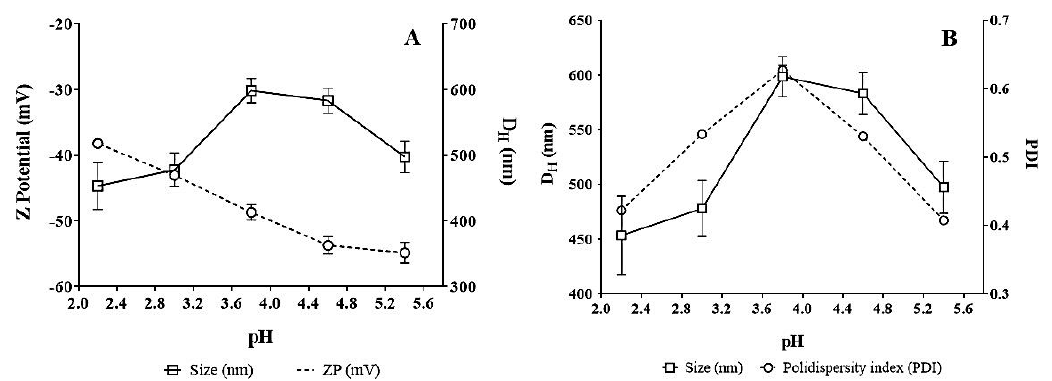
Figure 4. Effect of pH on: ( A ) zeta potential and ( B ) particle size (D H : Hydrodynamic Diameter) of optimized ethosomal system.